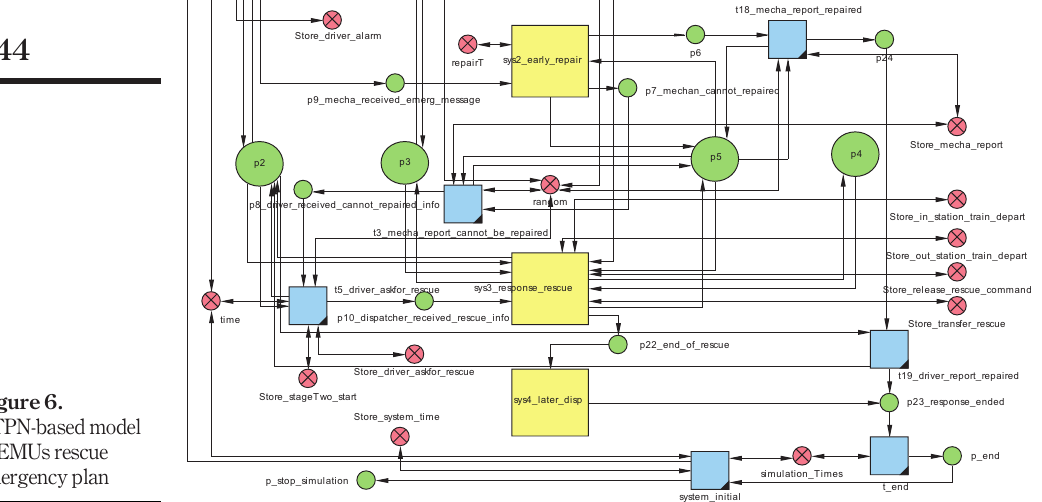
Figure 6. HTPN-based model of EMUs rescue emergency plan